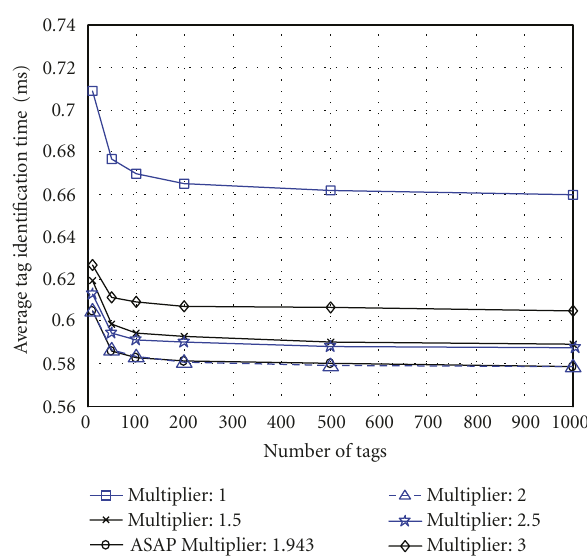
Figure 6: Ideal ASAP versus fixed frame size policies: average tag identification time.